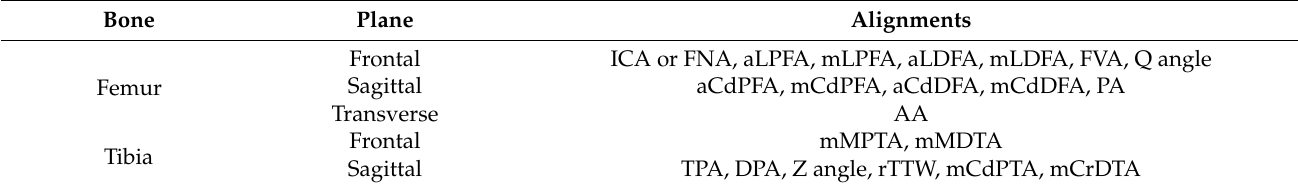
Table 3. Included femoral and tibial alignments in the frontal, sagittal, and transverse planes.